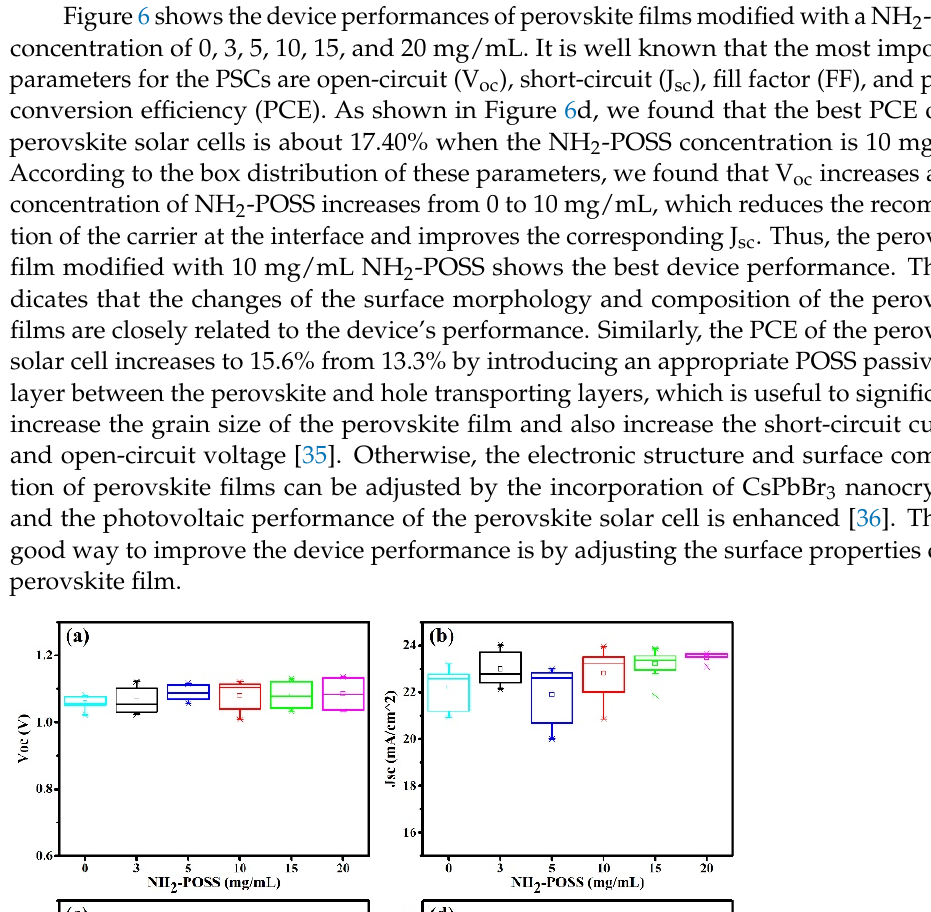
Figure S1: FTIR spectrum of perovskite with/without NH 2 -POSS; Table S1: XPS fitting data for per- ovskite films fabricated with different concentration of NH 2 -POSS.